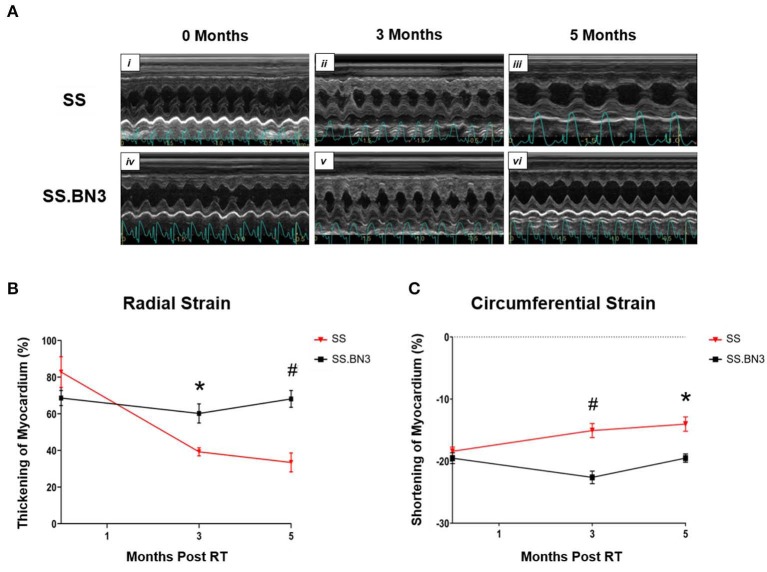
Echocardiograms indicated SS rats have decreased heart function compared with SS.BN3 rats after 24 Gy localized heart RT. (A) M-mode echocardiogram images of SS and SS.BN3 rats that received 24 Gy RT at baseline, 3 months, and 5 months post -RT. (B) Radial strain was lower in the SS rats at 3 and 5 months post-RT shown via decreased thickening of myocardium. (C) Circumferential strain also showed decreased function in SS vs. SS.BN3 at 3 and 5 months post-RT via decreased ability to contract, indicated by a smaller negative percentage. Values are means ± SEM. *P < 0.01, #P < 0.001.